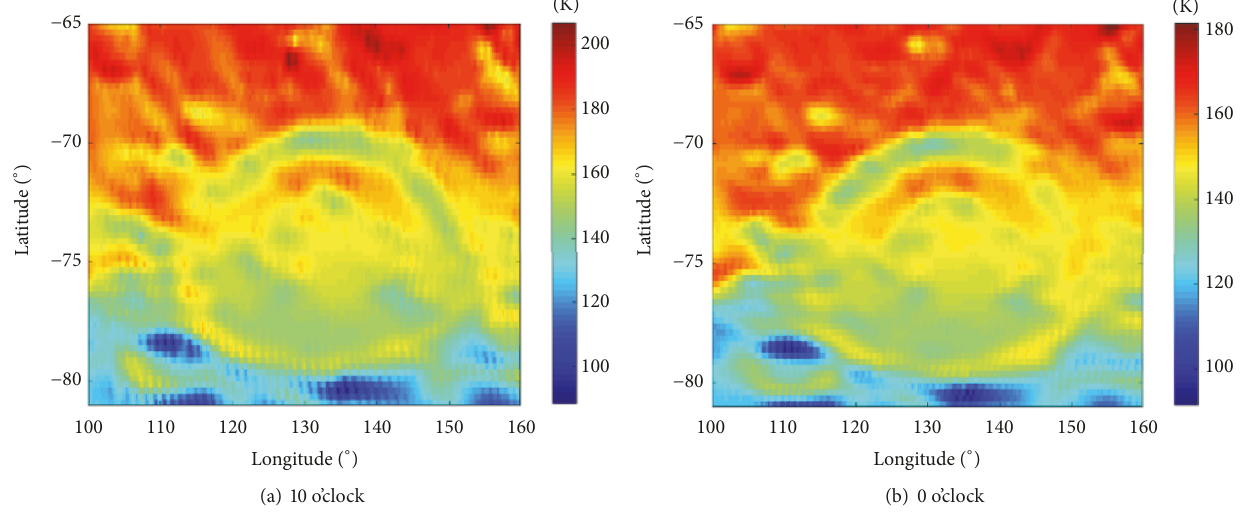
Figure 4: T distribution map of Schr¨odinger basin at 37 B